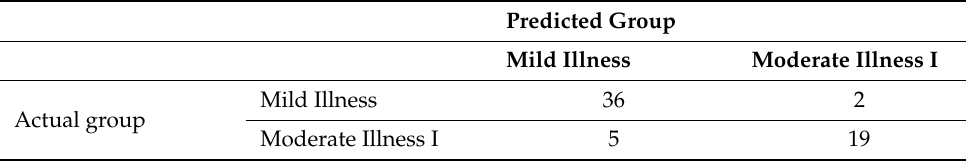
Table 12. Confusion matrix of /Ah/, /Eh/, and /Uh/.